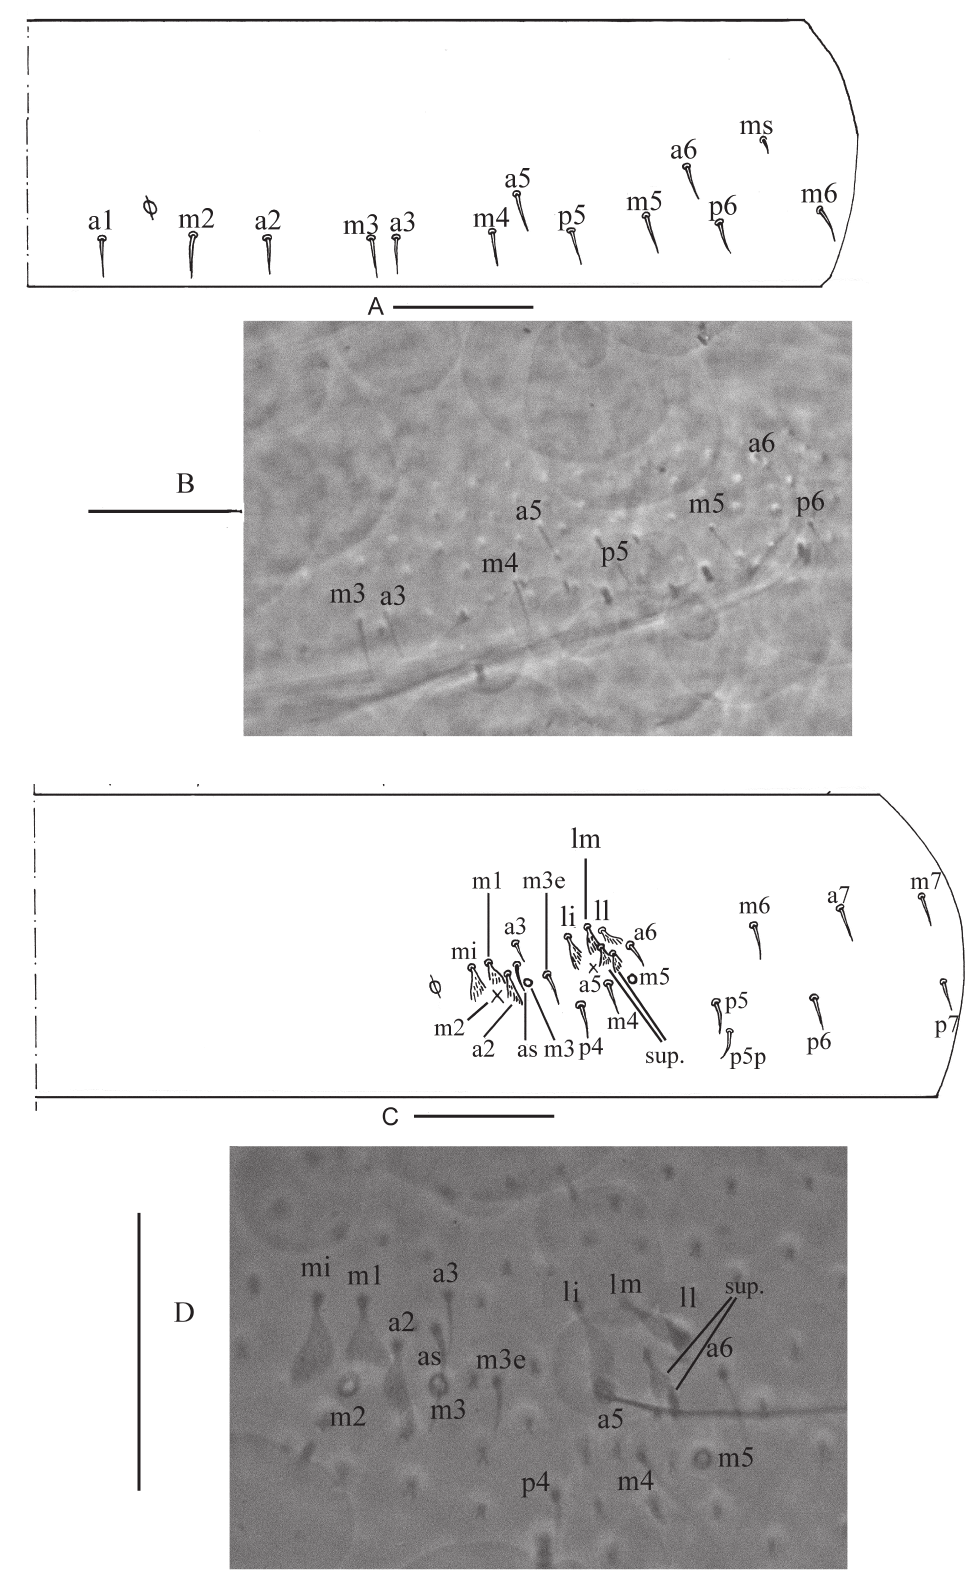
Fig. 5. Lepidocyrtus ( A. ) huizhouensis sp. nov., dorsal chaetotaxy (right side). A−B . Abd. I. C−D . Abd. II. Scale bars: 50